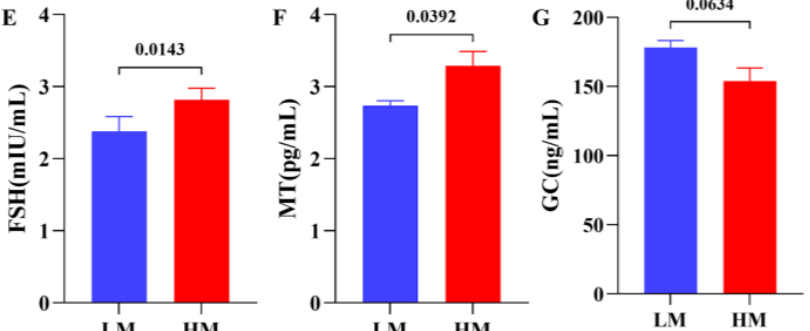
Figure 2. Serum physiological parameters between LM and HM groups: ( A ) LPS (lipopolysaccharides, pg/mL), ( B ) VD 3 (vitamin D3, ng/mL), ( C ) T (testosterone, ng/mL), ( D ) LH (luteinizing hormone, mIU/mL), ( E ) FSH (follicle-stimulating hormone, mIU/mL), ( F ) MT (melatonin, pg/mL), ( G ) GC (glucocorticoid, ng/mL). LM, low − motility group; HM, high − motility group.